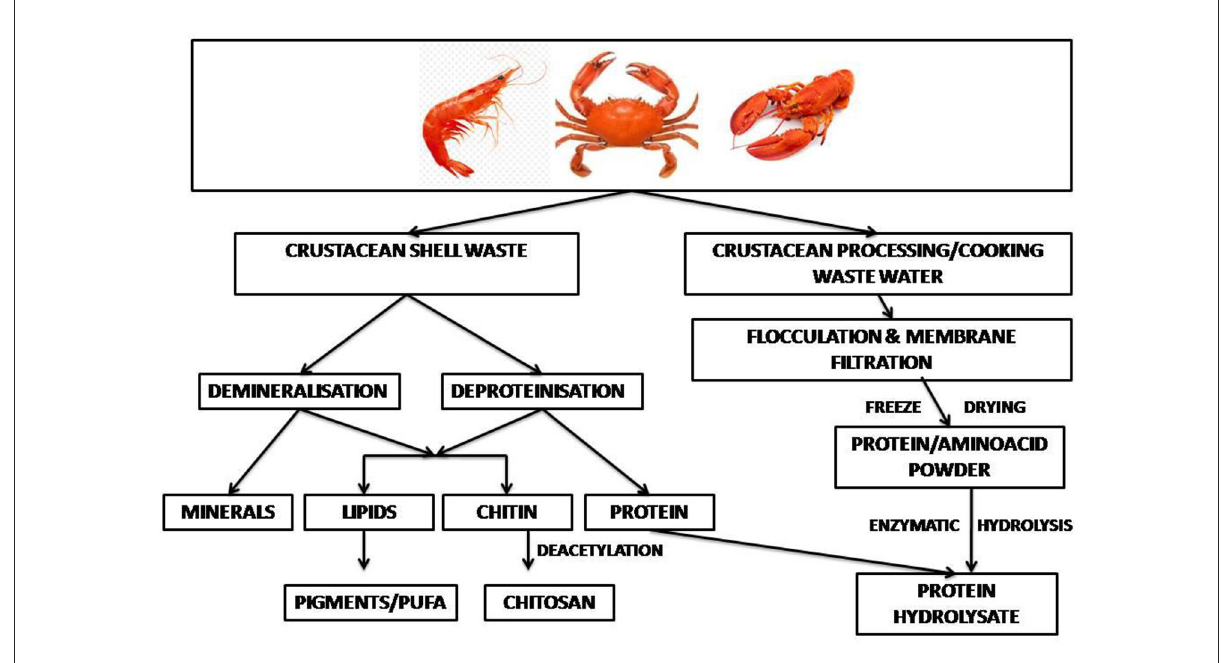
FIGURE3 Schematic diagram for c rustacean waste